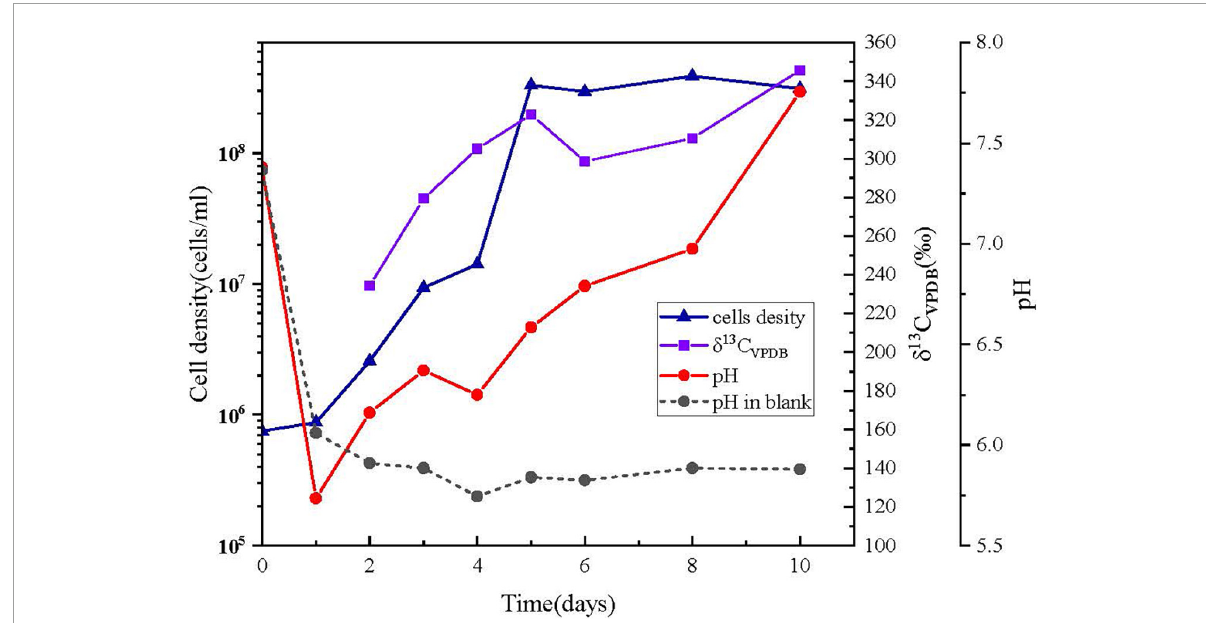
FIGURE4 Changing features of cells number, pH, and δ 13 C VPDB ( too less to measure the 13 C at day 1; ( • ) pH, symbols with solid line and short dash represent the inoculums and blank experiment,